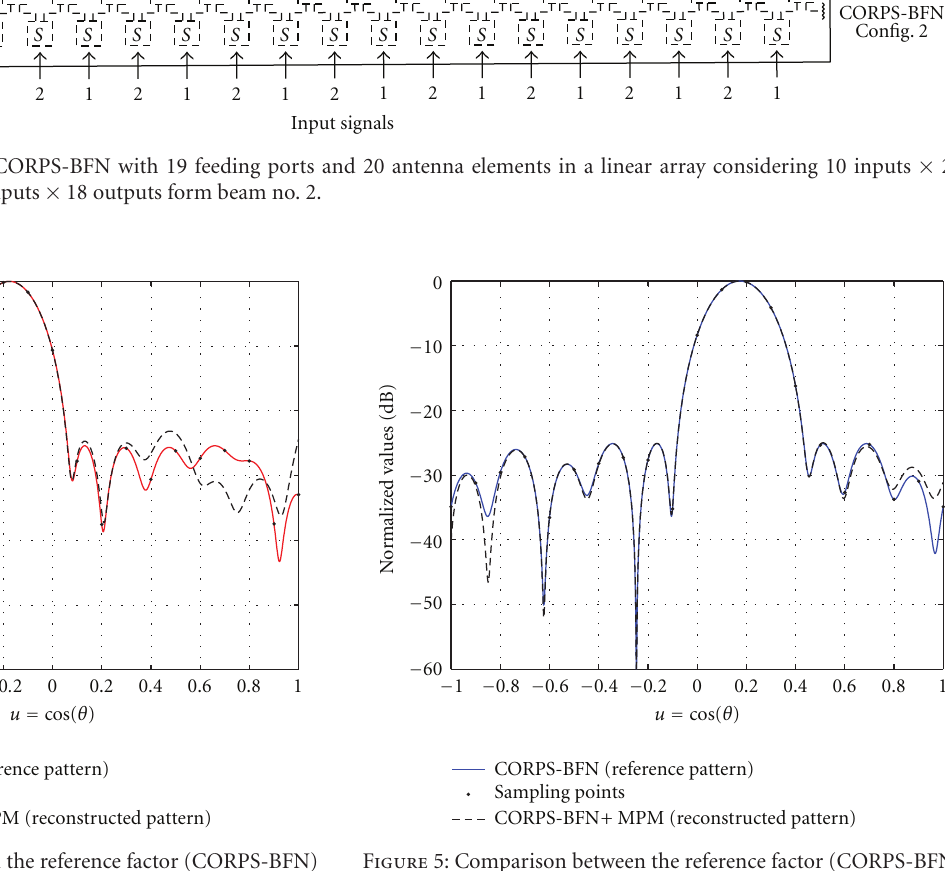
Figure 4: Comparison between the reference factor (CORPS-BFN) and the reconstructed factor (MPM + CORPS-BFN) obtained by the configuration 1 of the CORPS-BFN, showing an example of the beam no. 1 directed at 100 ◦ .